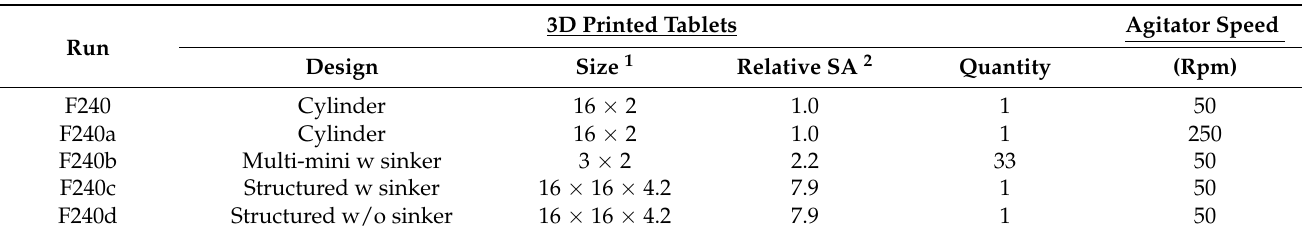
1 The units for the tablet size: Cylindrical geometry: mm × mm; slab geometry: mm × mm × mm. 2 Relative surface areas are dimensionless, as they are normalized by the SA of the regular cylindrical tablet, F240 (502.66 mm 2